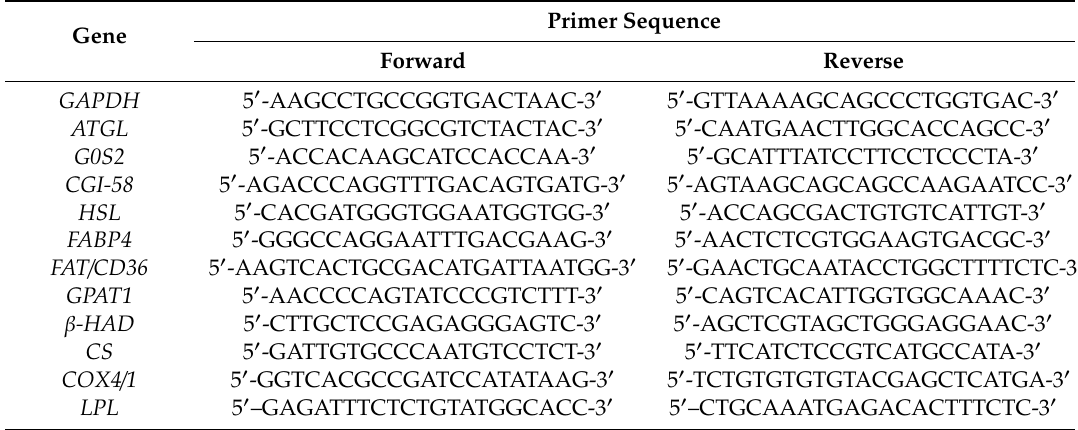
Table 5. Primers sequences for real-time PCR